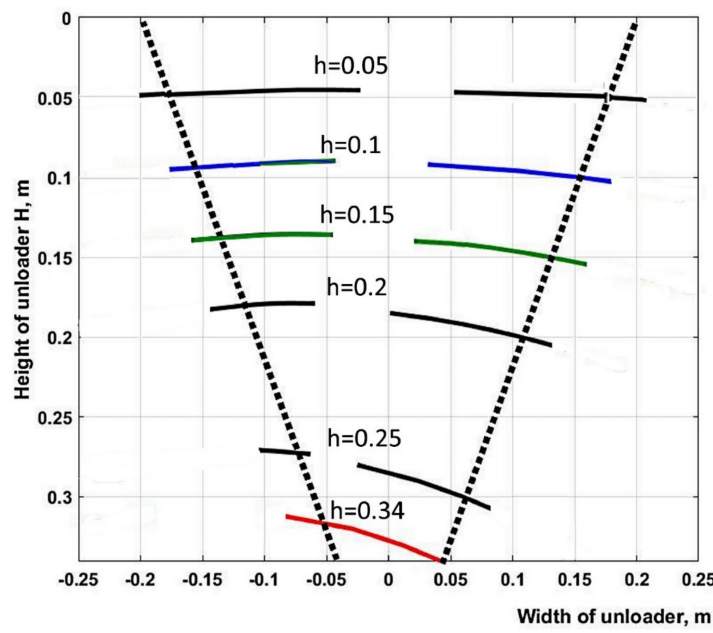
Figure 3. Family of curves representing surfaces of bridging formed by seeds moving from the upper edge of unloading hopper towards the outlet